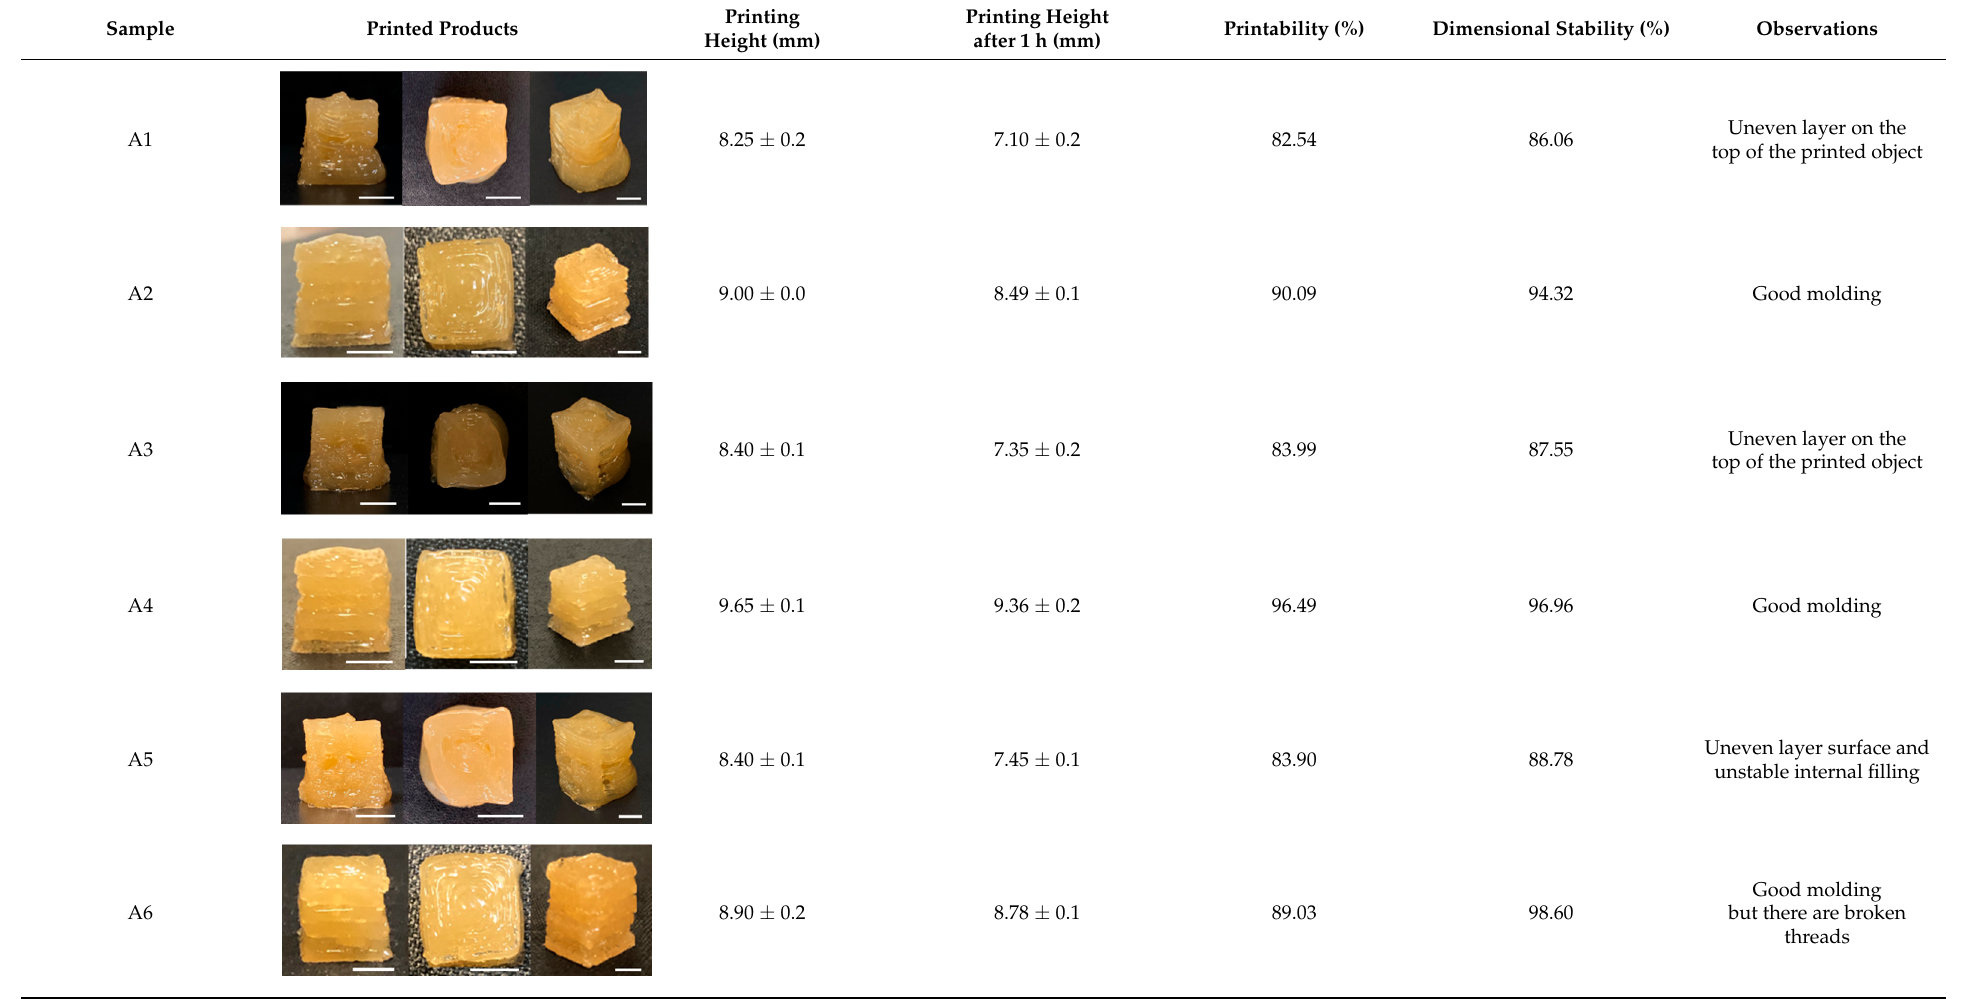
Table 3. Printing height and moldability of the printed gel as a function of gelatin, pectin, gum mixture, sugar, and citric acid content.